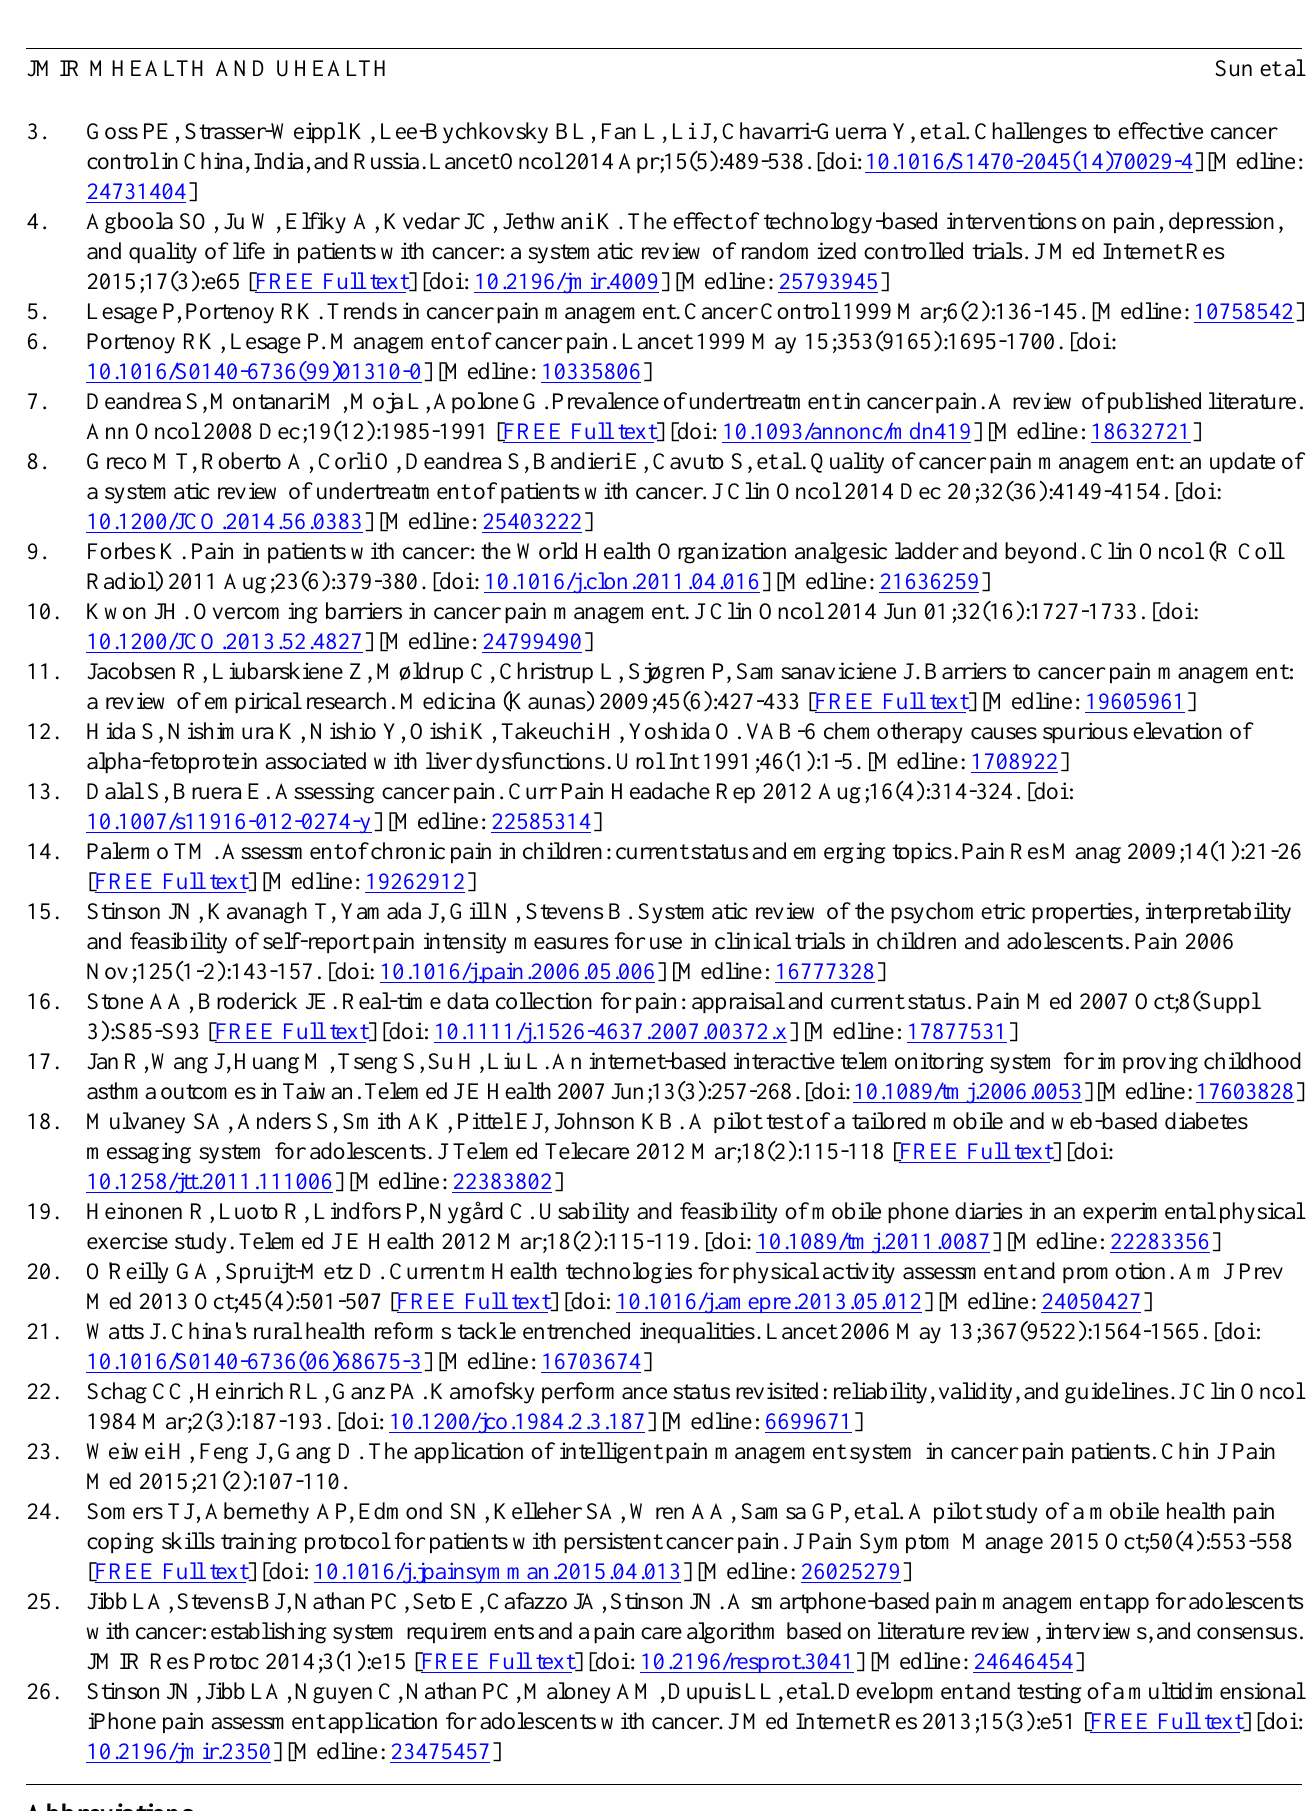
IPMS: intelligent pain management